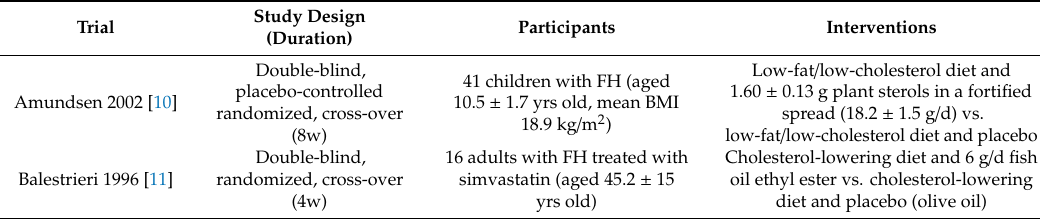
Table 1. Characteristics of the included trials.